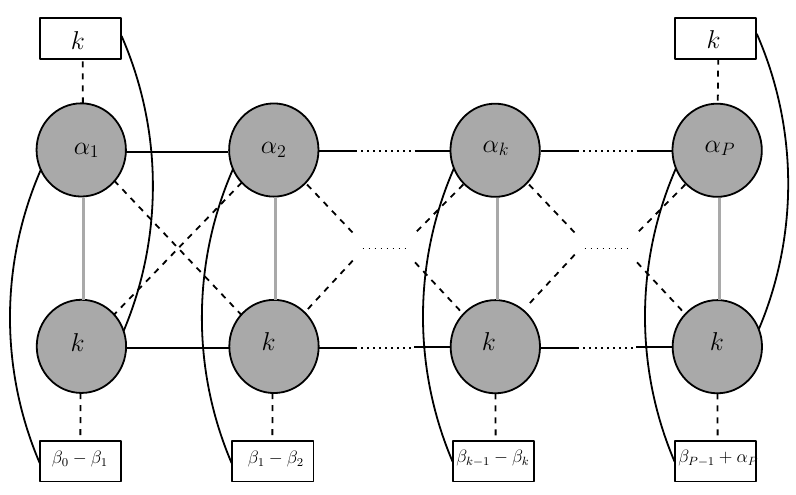
Figure 2 . Generic quiver field theory dual to the AdS 3 solutions in Type IIB with ξ = 0